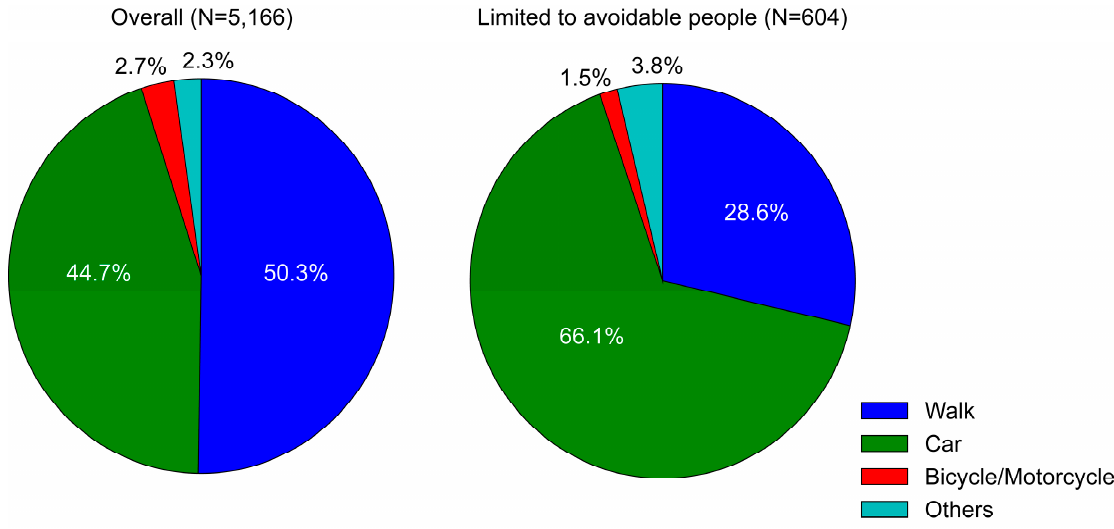
Figure 10. Evacuation mode preference for future tsunami